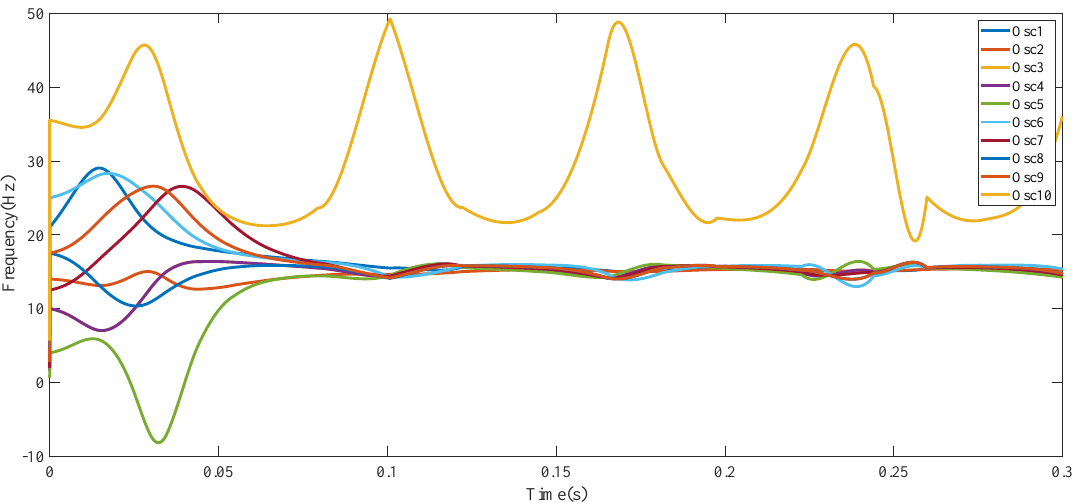
Figure 5. Coupled ONN behavior displays lack of